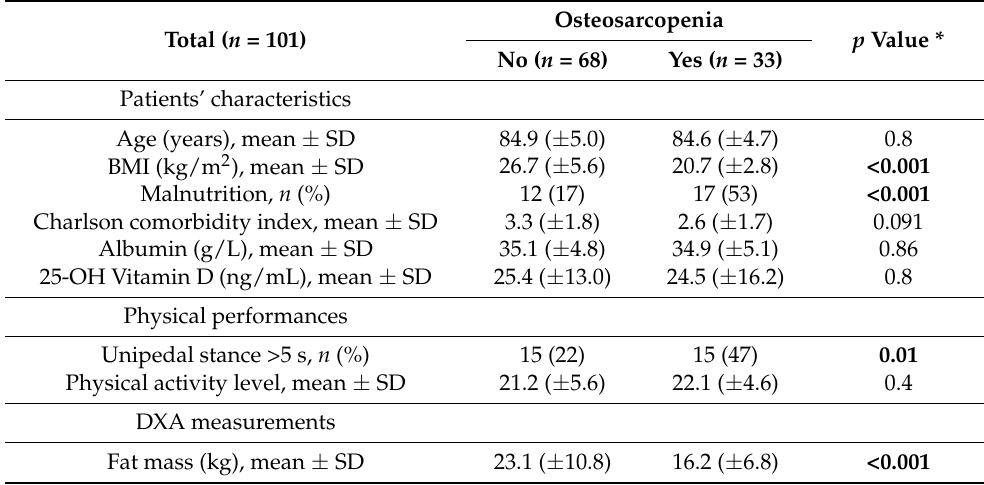
Table 5. Patients’ characteristics according to osteosarcopenia diagnosis ( n =